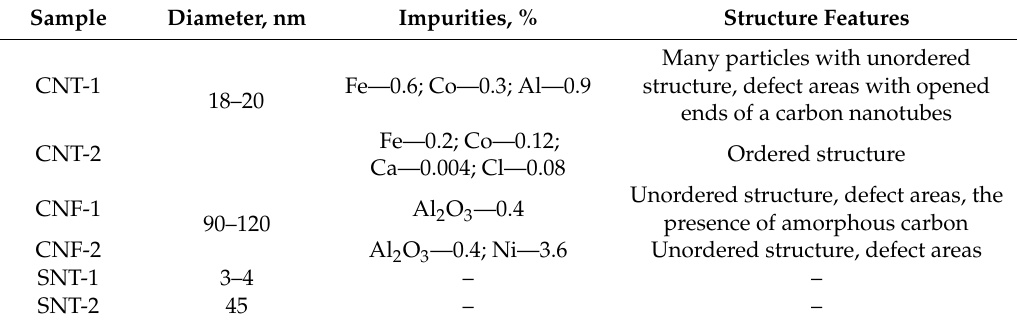
Table 1. Characteristics of the nanoparticles used in this